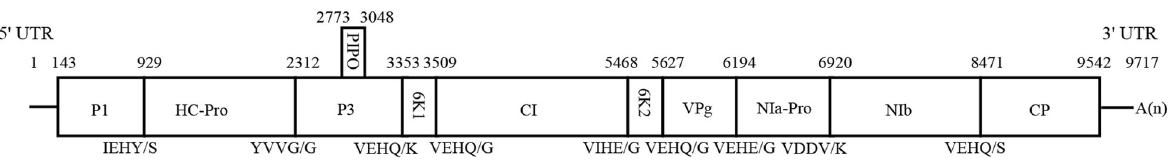
Fig. 3 Schematic diagram of the genomic organization of PalMV. Two short horizontal lines represent 5 ′ and 3 ′ UTRs, respectively. The largest box represents the long ORF. The smaller boxes represent the mature proteins. The smallest box represents PIPO derived from RNA polymerase slippage on the P3 cistron. The putative cleavage sites are marked below the